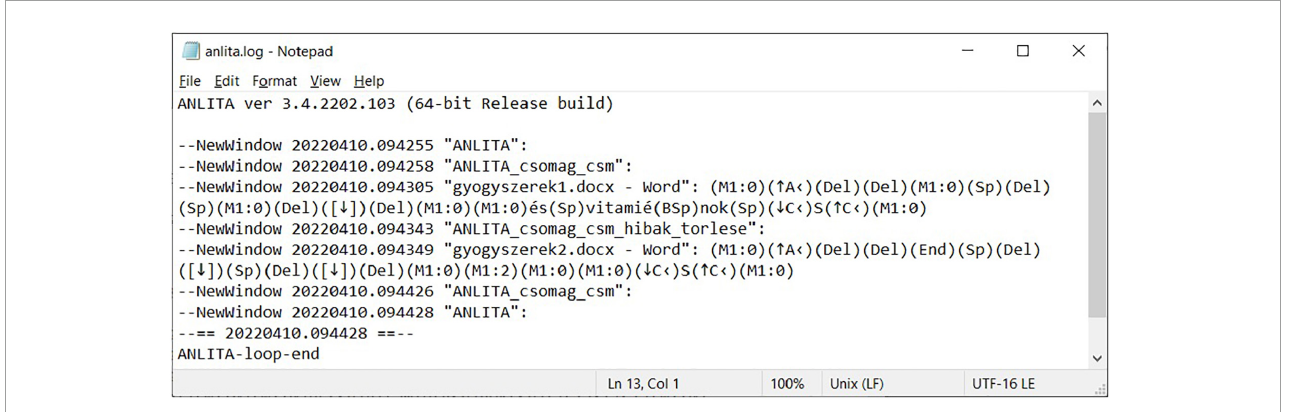
FIGURE11 User input events in an ANLITA log, inserting words into the erroneous document with the corrective